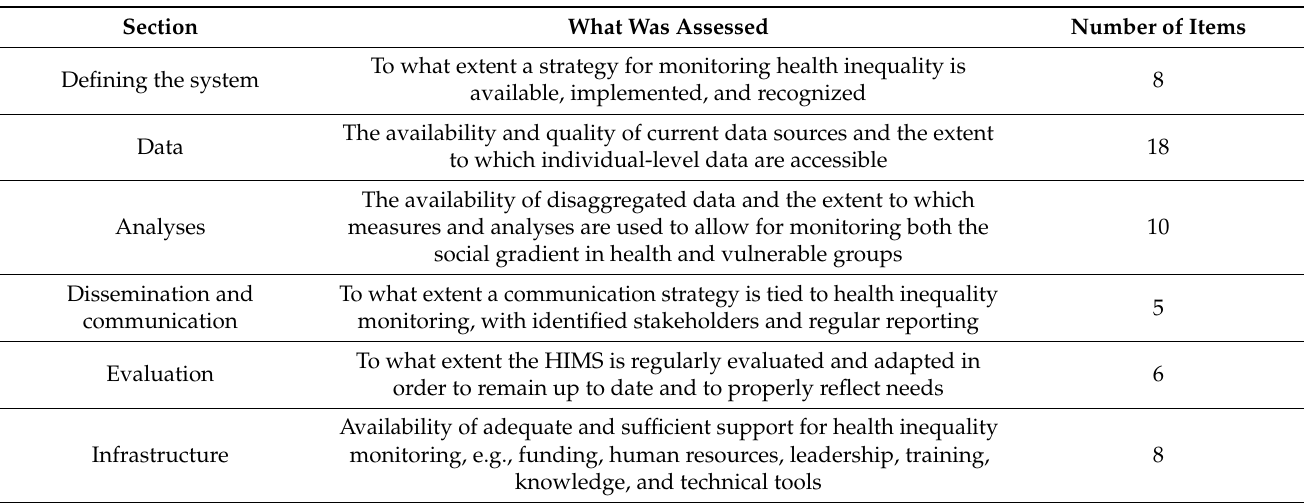
Table 2. Overview of survey sections, what was assessed in each section, and the number of